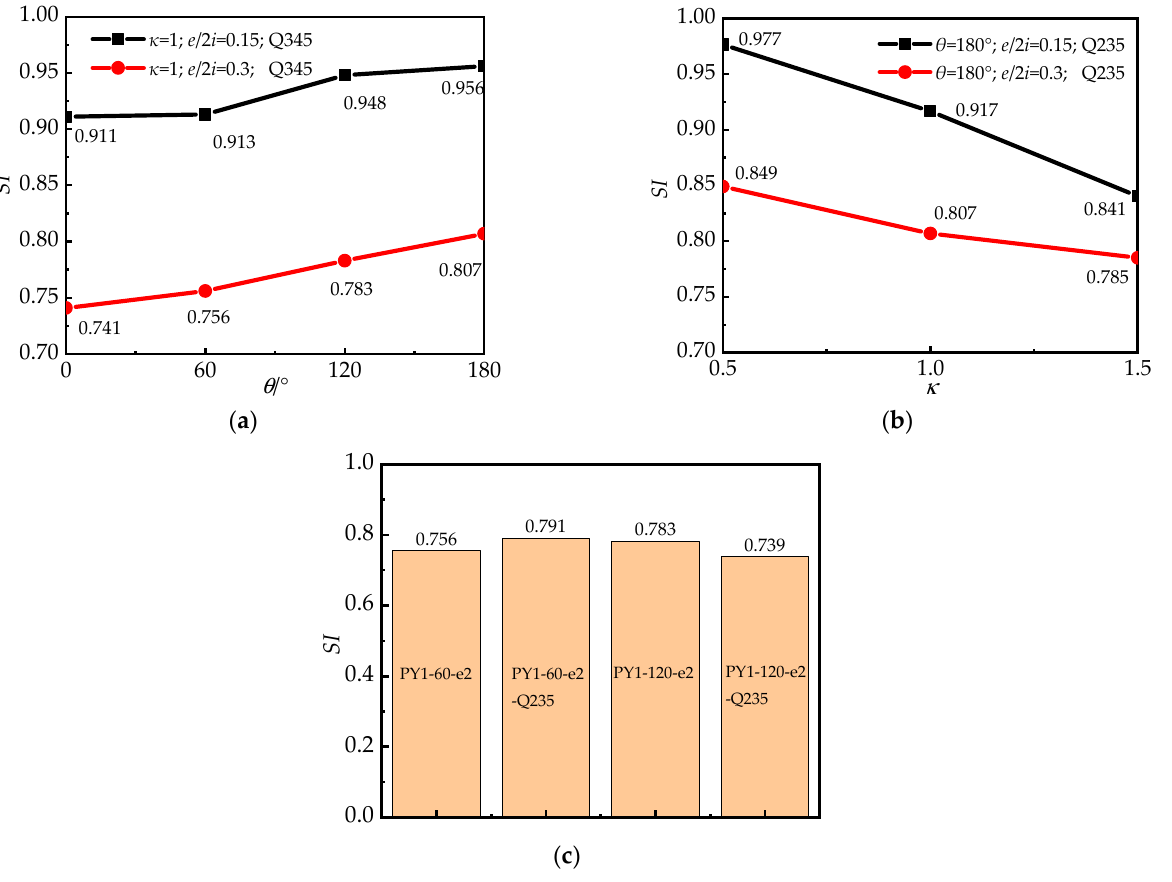
Figure 9. SI for columns with different paraments: ( a ) central angle, θ ; ( b ) aspect ratio of cross-section, κ ; ( c ) strength of steel tube, f y .